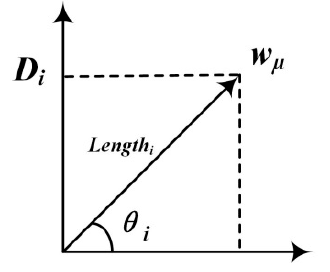
Figure 2. An example of DisVector .